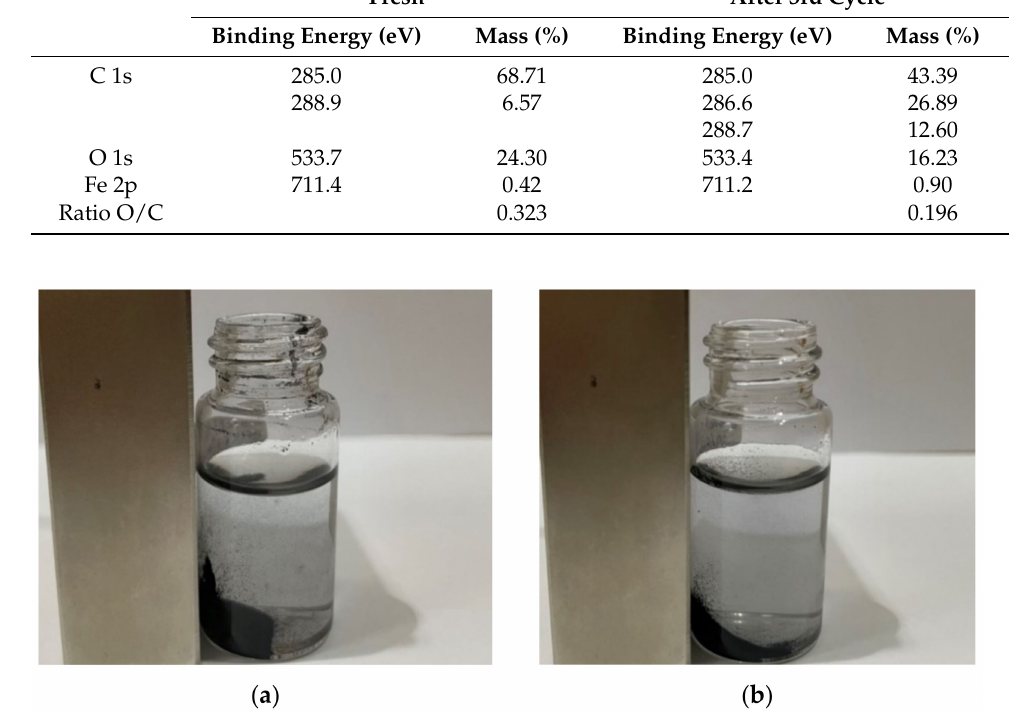
Figure 8. Magnetic separation of 0.5FePt/AC catalyst ( a ) after 1st cycle run and ( b ) after 3rd cycle